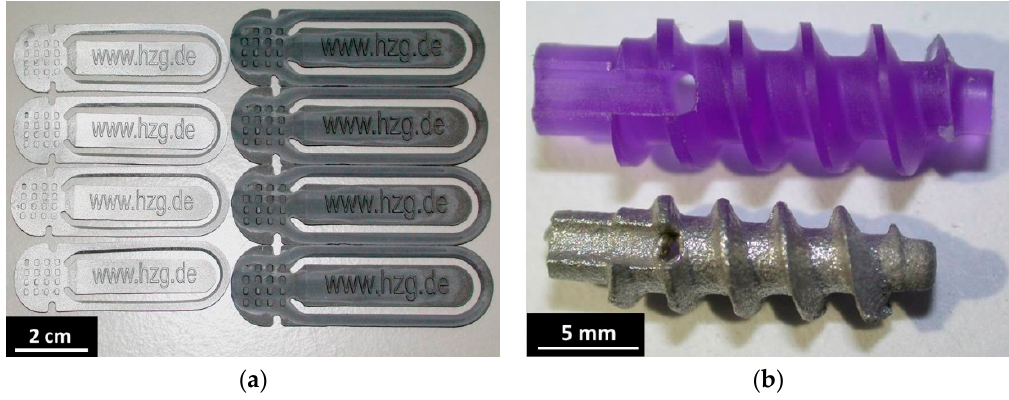
Figure 1. ( a ) Bookmark demonstrator parts made by metal injection molding (MIM) of Mg ‐ 0.9Ca feedstock at Helmholtz ‐ Zentrum Geesthacht. The parts on the left are in the as sintered condition; the parts on the right are the corresponding green parts. The shrinkage of the sintered parts is very clearly visible in comparison to the size of the green parts. ( b ) Suture anchor screws produced by injection molding technique using the same mold: (1) Lower screw shows a sintered part produced by MIM of Mg ‐ 0.9Ca feedstock from Mg ‐ 0.9Ca powder blend at the Helmholtz ‐ Zentrum Geesthacht (HZG); (2) Upper screw made from PLDLA (poly L ‐ lactide/ DL ‐ lactide copolymer), using the same mold as the MIM Mg ‐ 0.9Ca screw. Courtesy: Conmed Linvatec.